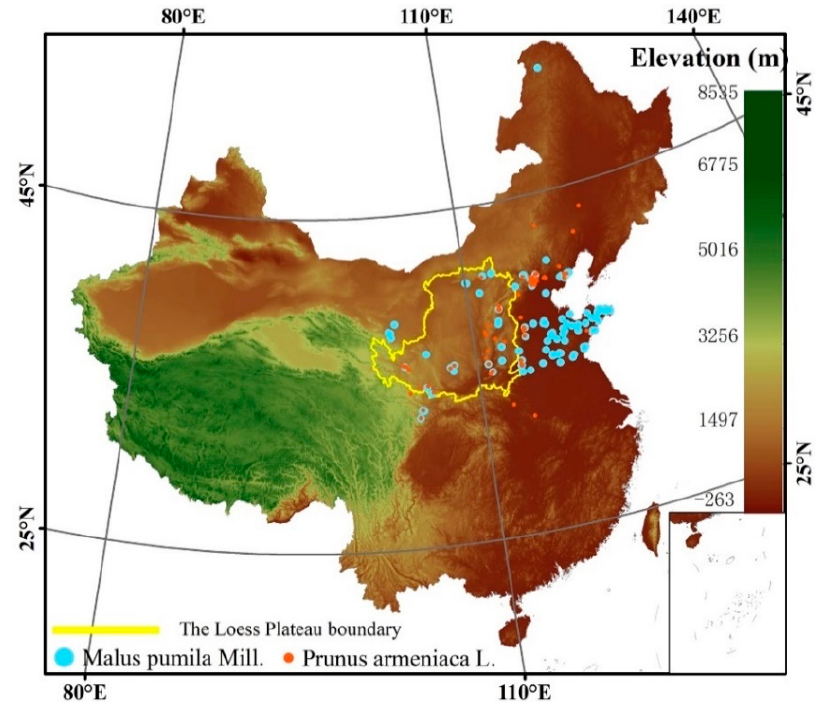
Figure 1. Occurrence records of Malus pumila Mill. and Prunus armeniaca L. in China. Different colored dots represent the sites of species and yellow lines show the range of the study area, the Loess Plateau.